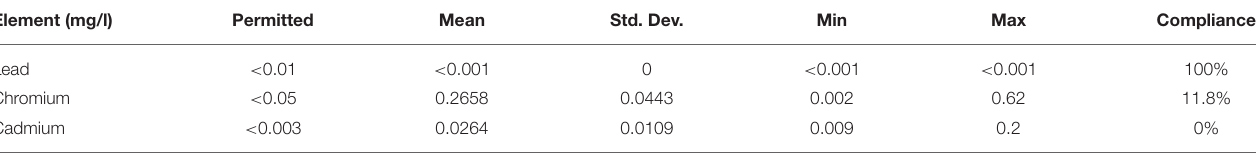
TABLE 4 | Concentrations of lead, chromium, and cadmium. Element